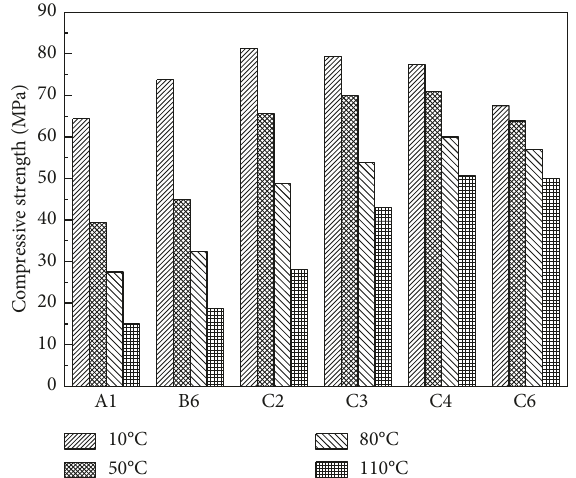
Figure 5: Variation of compressive strength with temperature for anchorage agent with different